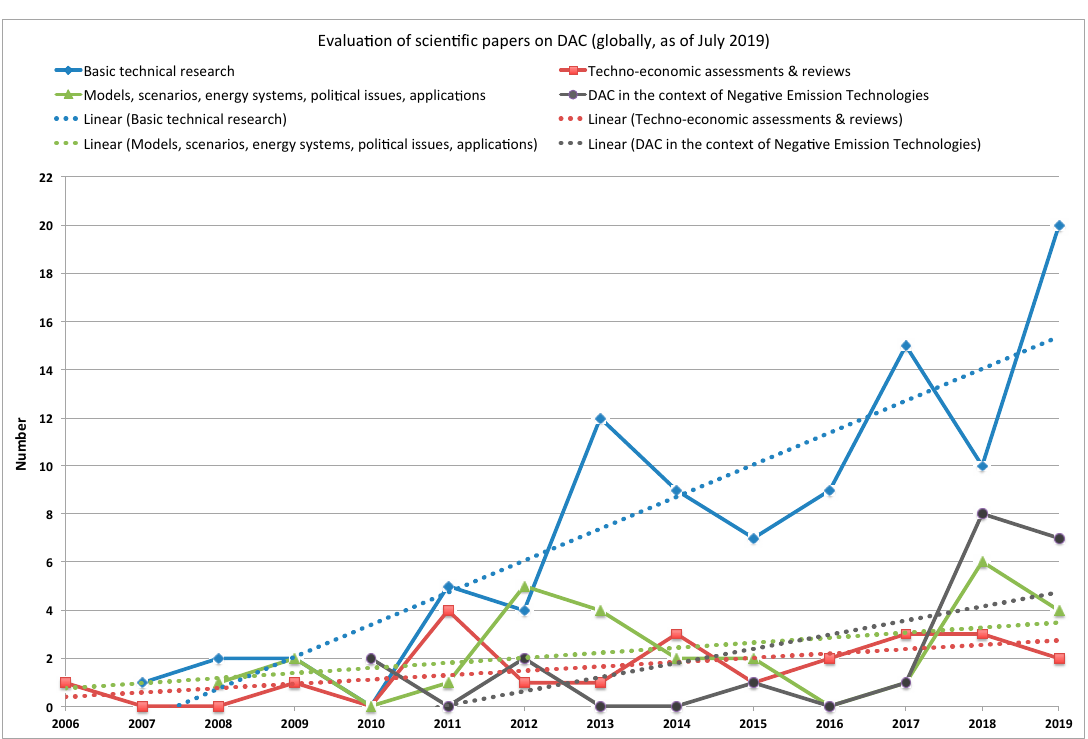
Figure 4. Evaluation of scientific articles on Direct Air Capture (DAC).